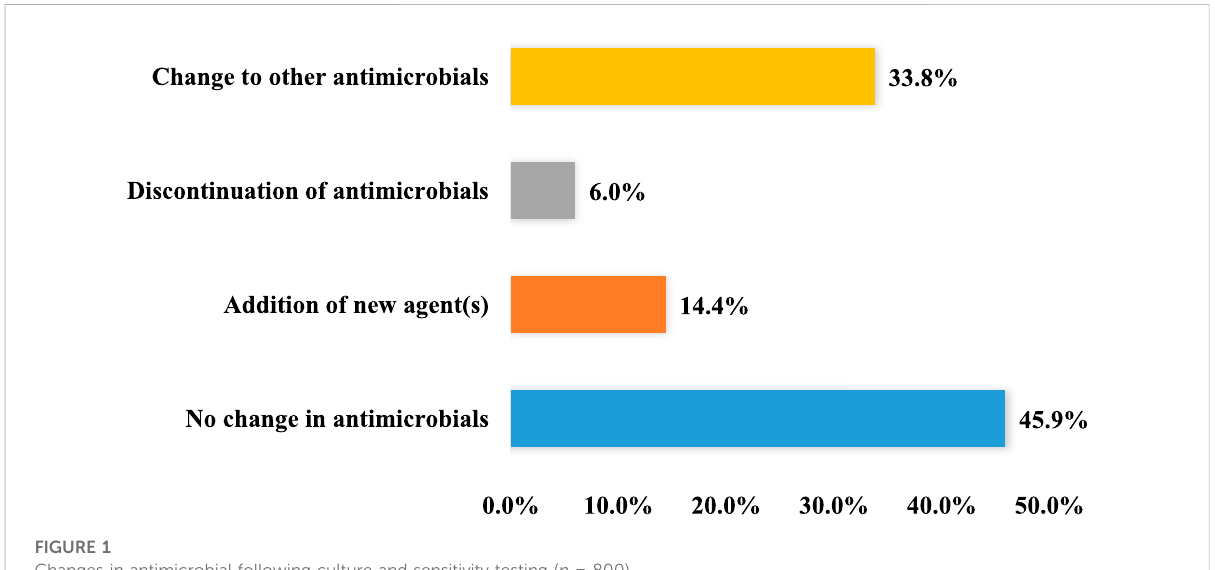
FIGURE 1 Changes in antimicrobial following culture and sensitivity testing ( n =